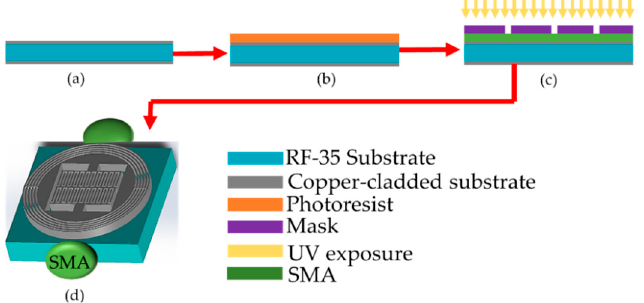
Figure 5. Fabrication steps of the proposed prototype: ( a ) RF-35 substrate with copper decoration on both sides; ( b ) photoresist layer on the backside of the film; ( c ) patterned mask on the film with UV light exposure for moving design on the substrate; ( d ) the proposed microwave sensor with SMA connectors.